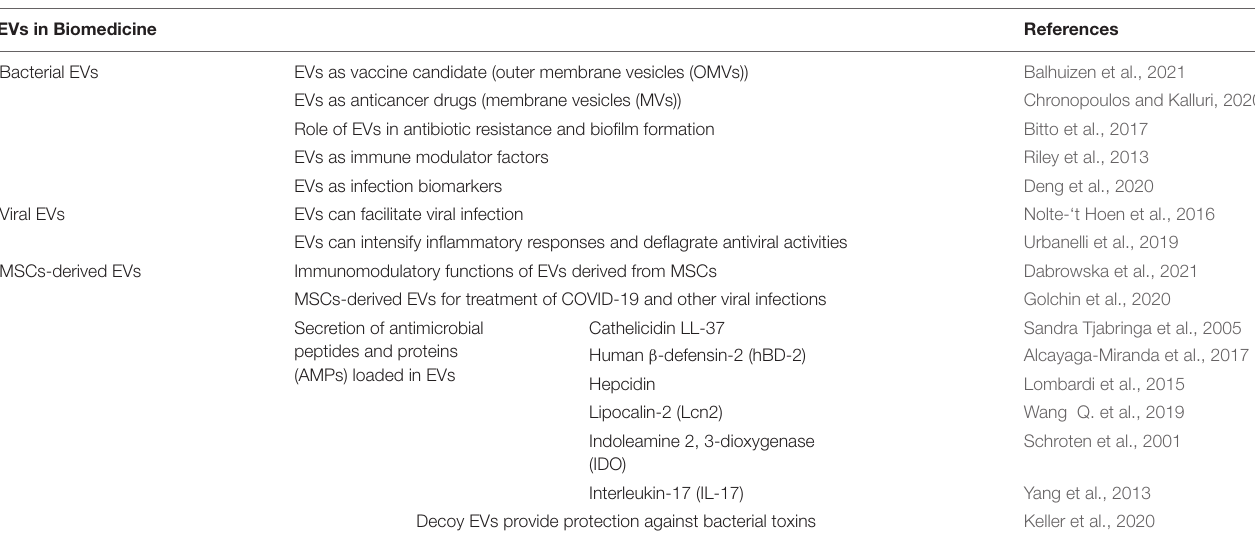
TABLE 1 | Current biomedical applications of Extracellular